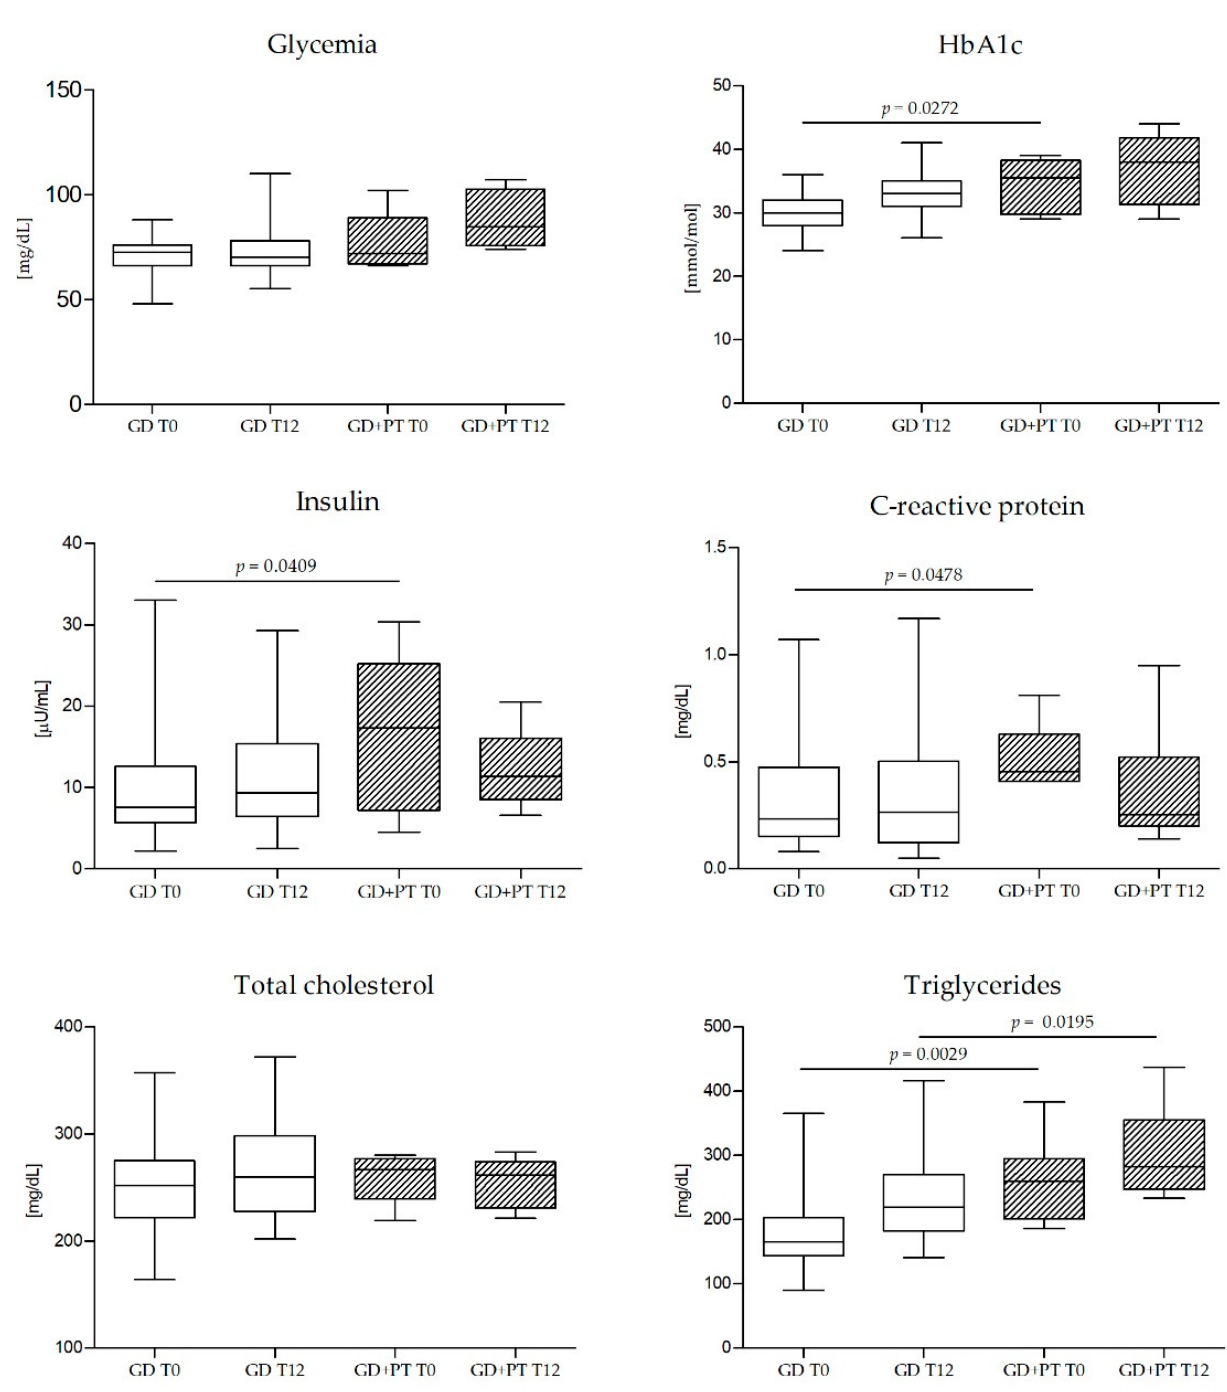
Figure 3. Longitudinal trend of plasmatic metabolic and inflammatory parameters of subjects with GD who required therapy to normalize blood glucose levels (GD+PT) at enrollment (T0; n = 6) and at the end of the study after 12 weeks (T12; n = 6) with subjects who did not require pharmacological intervention (GD) at T0 ( n = 45) and at T12 ( n = 34). GD—subjects with gestational diabetes mellitus who did not require pharmacological therapy. GD+PT—subjects with gestational diabetes mellitus who required pharmacological therapy. T0—at enrollment. T12—after 12 weeks.